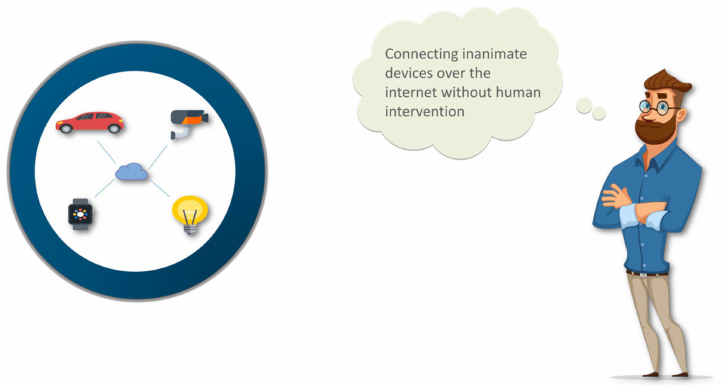
Figure 1. The concept of the Internet of